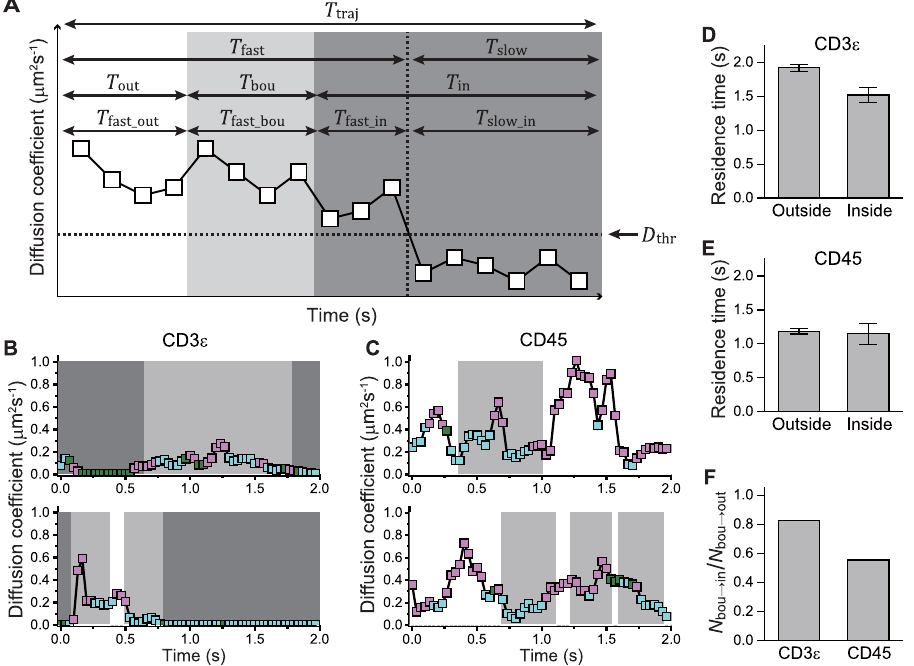
Figure 4. Single-molecule trajectories of CD3 ε and CD45 relative to TCR microclusters on the cell membrane of a living Jurkat cell. ( A ) Schematic representation of trajectory durations, residence times, dissociated-state durations, and associated-state durations for lifetime and kinetics analyses. Each square indicates the diffusion coefficient of a single subtrajectory. The locations of the subtrajectories relative to the microclusters are indicated by background colors: inside (white), boundary (light gray), and outside (gray). ( B,C ) Representative time courses of the diffusion coefficient D of CD3 ε ( B ) and CD45 ( C ) obtained by the moving subtrajectory MSD analysis. The three diffusion types are shown as follows: simple (green square), directional (cyan square), and confined (magenta square). The squares and the background colors are the same as in ( A ). ( D,E ) Lifetimes of the residence times of CD3 ε ( D ) and CD45 ( E ) on the inside and outside of the microclusters. ( F ) Ratio